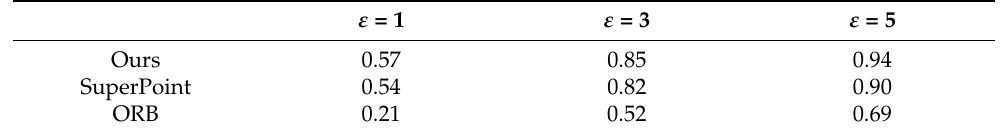
Table 1. Homography Estimation on Hpatches.